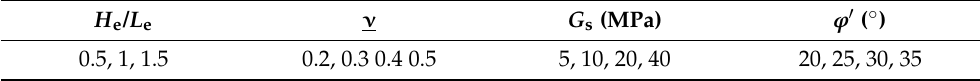
Table 4. Variables in the parametric study.